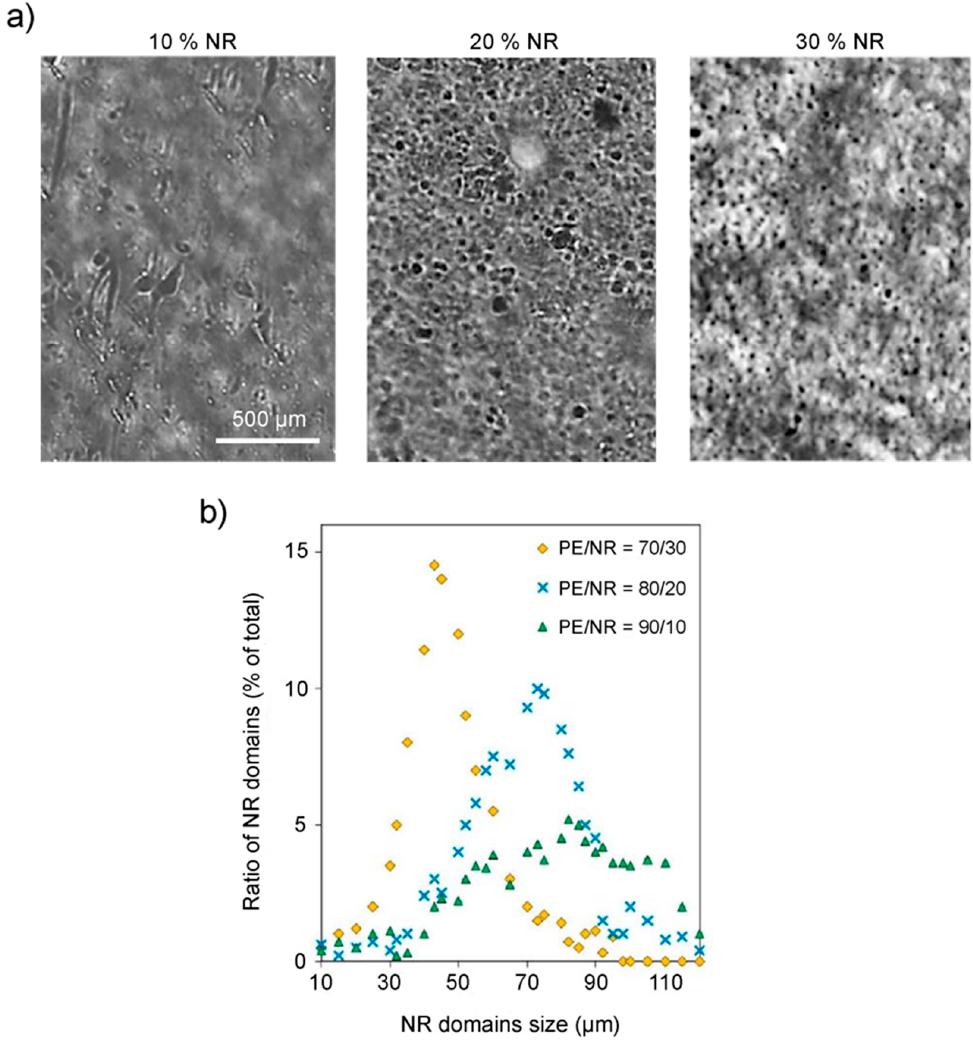
Figure 9. ( a ) Micrographs of composite samples of PE/NR containing 10, 20 and 30 wt.% NR, made in transmitted light at a magnification of 200×. ( b ) Size distribution of NR domains in PE/NR composites containing 10, 20, and 30 wt.% NR. Adapted from Mastalygina Elena et al. [52]. When the NR content is 10 wt.%, the elongation at break decreases four times compared to the elongation of pure PE films. No further changes in the relative elongation